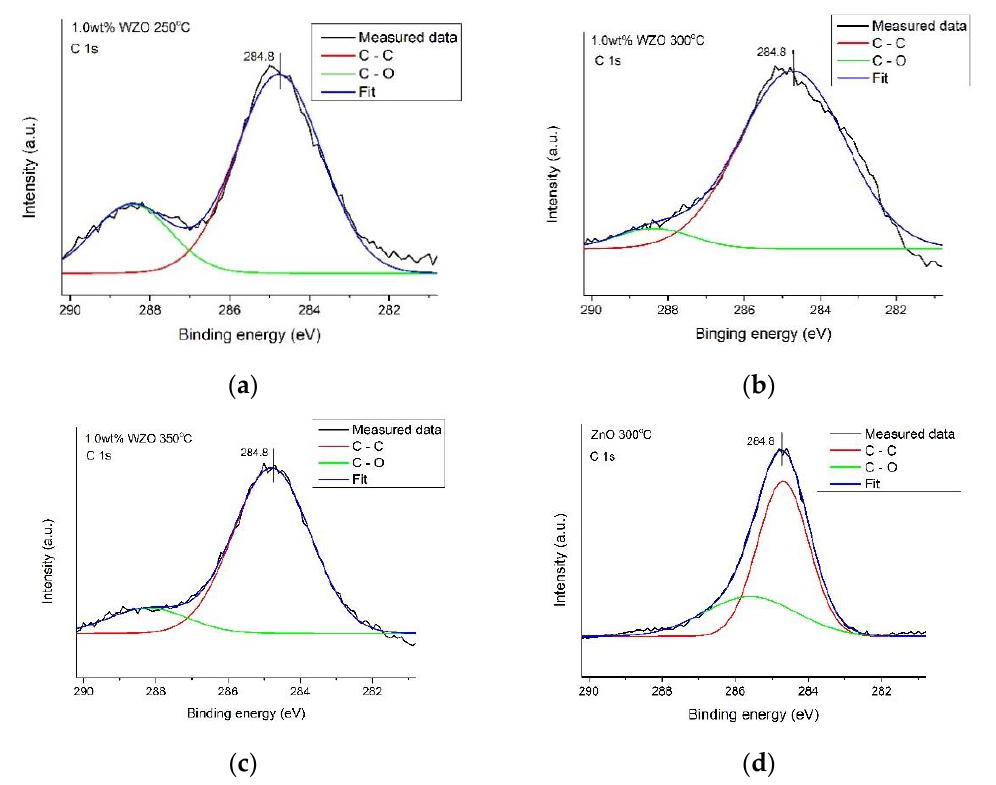
Figure 12. C 1s peak intensity of 1.0 wt.% WZO films grown at ( a ) 250 °C, ( b ) 300 °C, ( c ) 350 °C, and ( d ) ZnO film grown at 300 °C. The O 1s XPS peaks of the ZnO film grown at 300 ◦ C and 1.0 wt.% WZO films grown